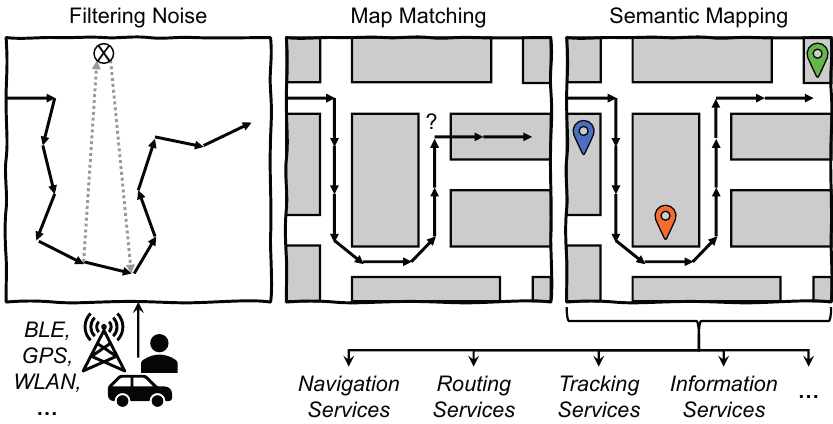
Figure 1. Examples of Data Refinement Steps for Trajectory